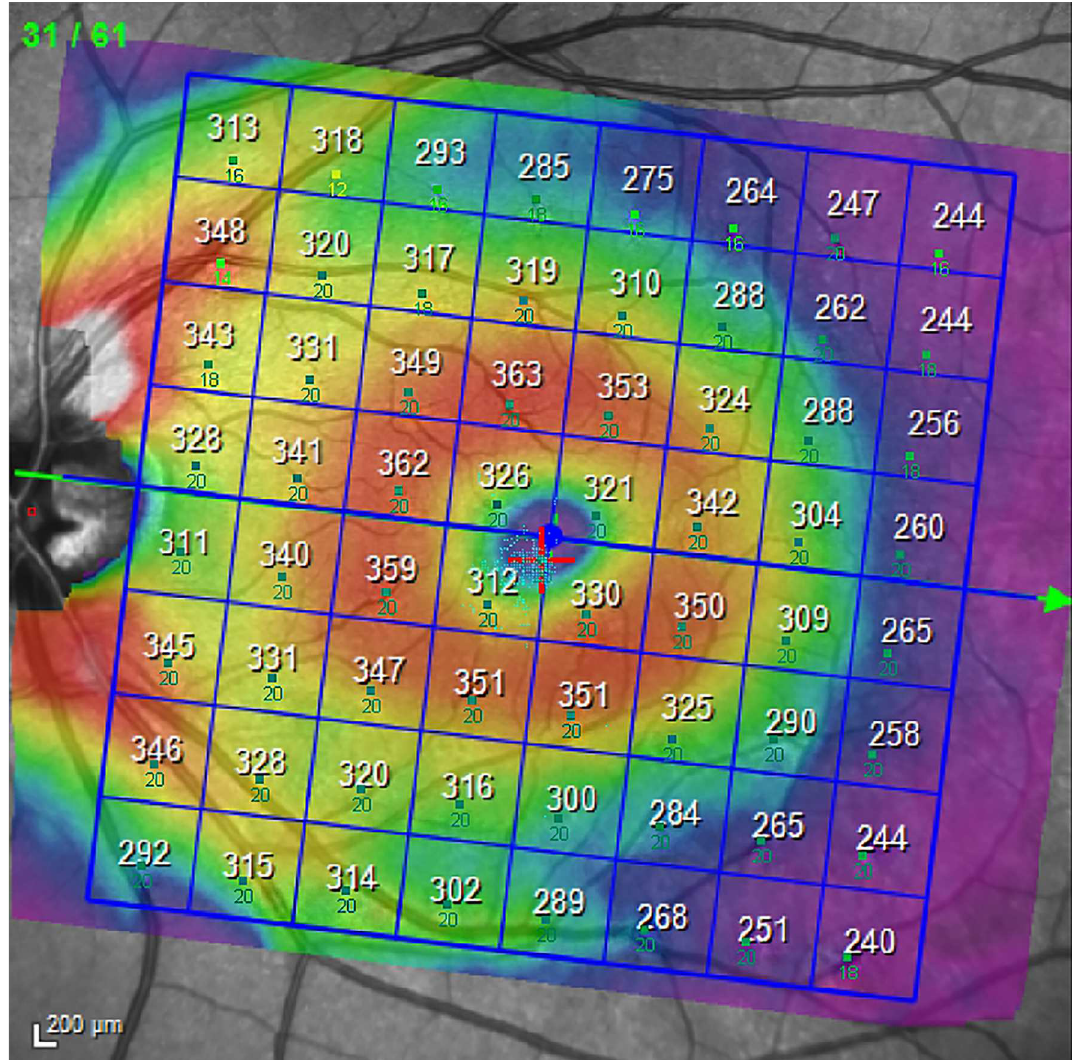
Fig 2. Combination map of SD-OCT PP total retina and MP1 PP